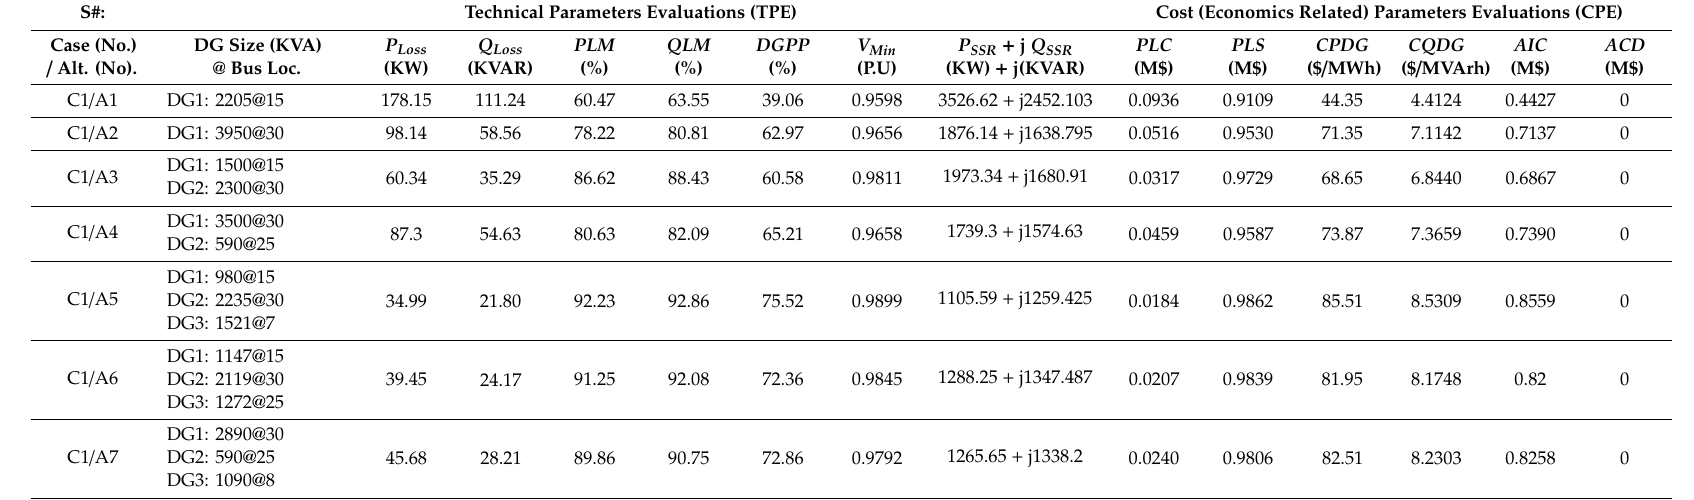
Table 21. Techno-economic evaluation analysis in case 1 (C1_OLG) for 33-bus